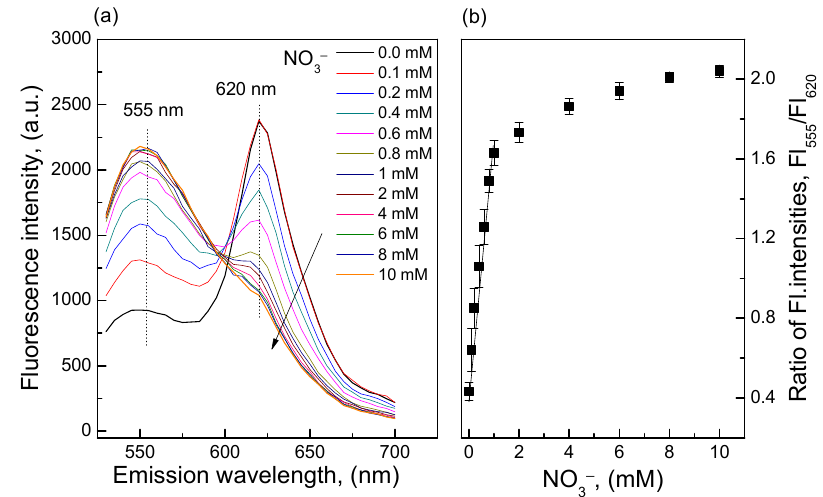
Figure 4. ( a ) Fluorescence emission spectra of the O17-HT-EC membrane when exposed to different nitrate concentrations; ( b ) Calibration curve of the O17-HT-EC membrane in the nitrate concentration range of 0.1–10 mM.